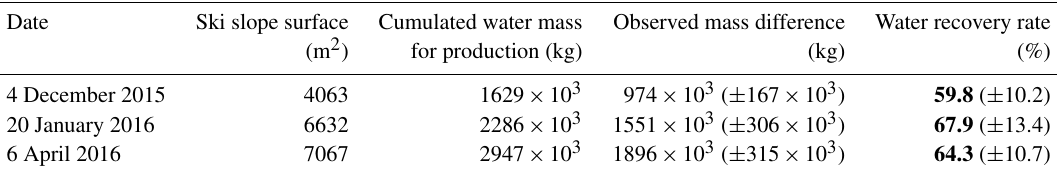
Table 9. Water recovery rate (Average value in bold ± σ ) from observations of the snow mass difference between ski slope snow conditions and simulated groomed snowpack conditions (i.e. without snowmaking).